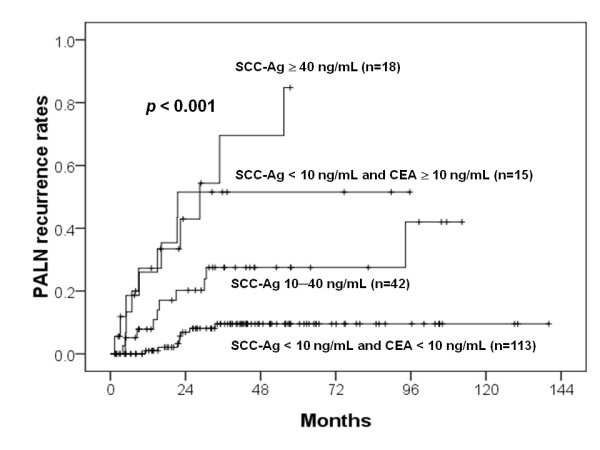
PALN recurrent rates for various combinations of pretreatment of CEA and SCC-Ag levels.